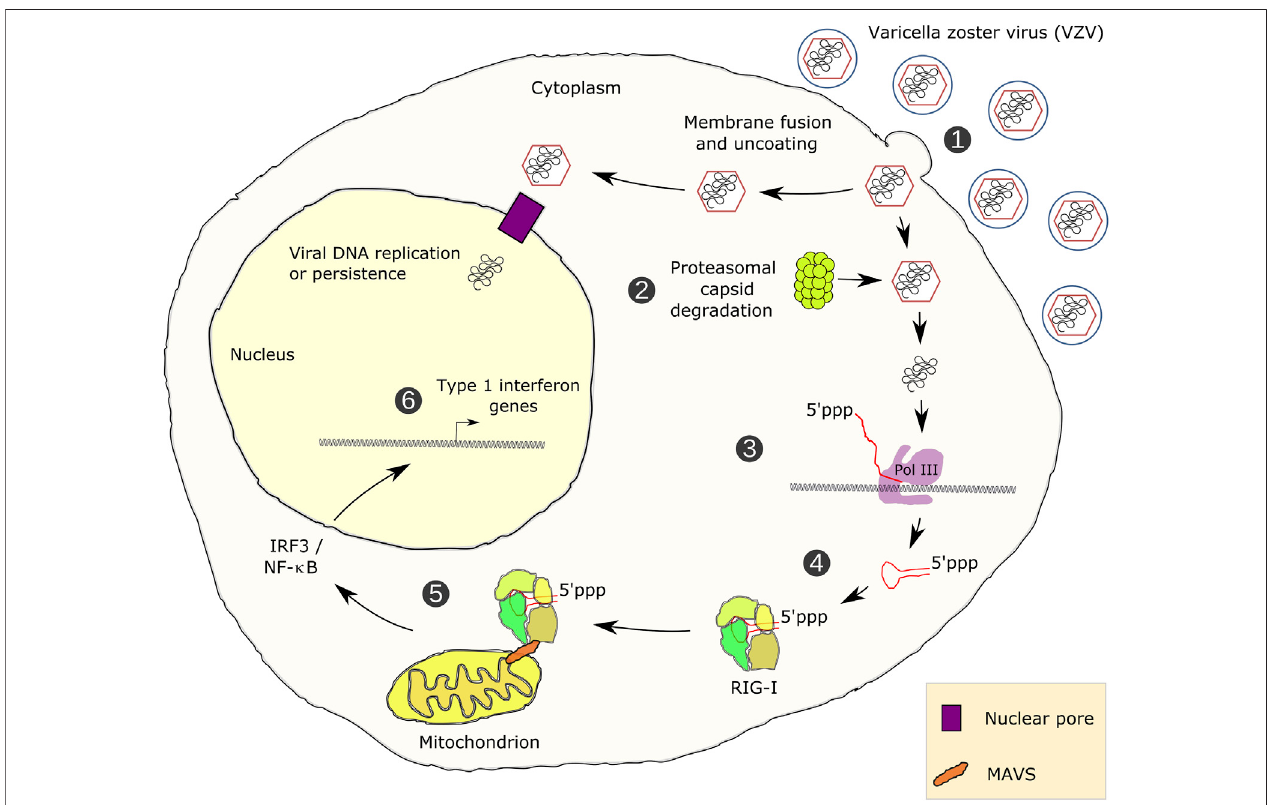
FIGURE 10 | Cytoplasmic transcription by RNA polymerase III in innate immune defense. Upon infection (1), the varicella zoster virus (VZV) DNA is found in the nucleus and the cytoplasm (Mahalingam et al., 1999; Zerboni et al., 2014). Although not speci fi cally reported for VZV, cytoplasmic liberation of DNA from capsids may involve proteasomal degradation (2), as was described for herpes simplex virus 1 (HSV-1; Horan et al., 2013). Cytoplasmic AT-rich VZV DNA is transcribed by Pol III (3), the 5 ′ tri-phosphorylated RNA folds into stem-loop structures, interacts with the retinoic acid-inducible gene I (RIG-I) (4), which, via mitochondrial antiviral signaling (MAVS) protein and NF-kB/IRF3 transcriptional activators (5) increases transcription of type I interferon genes